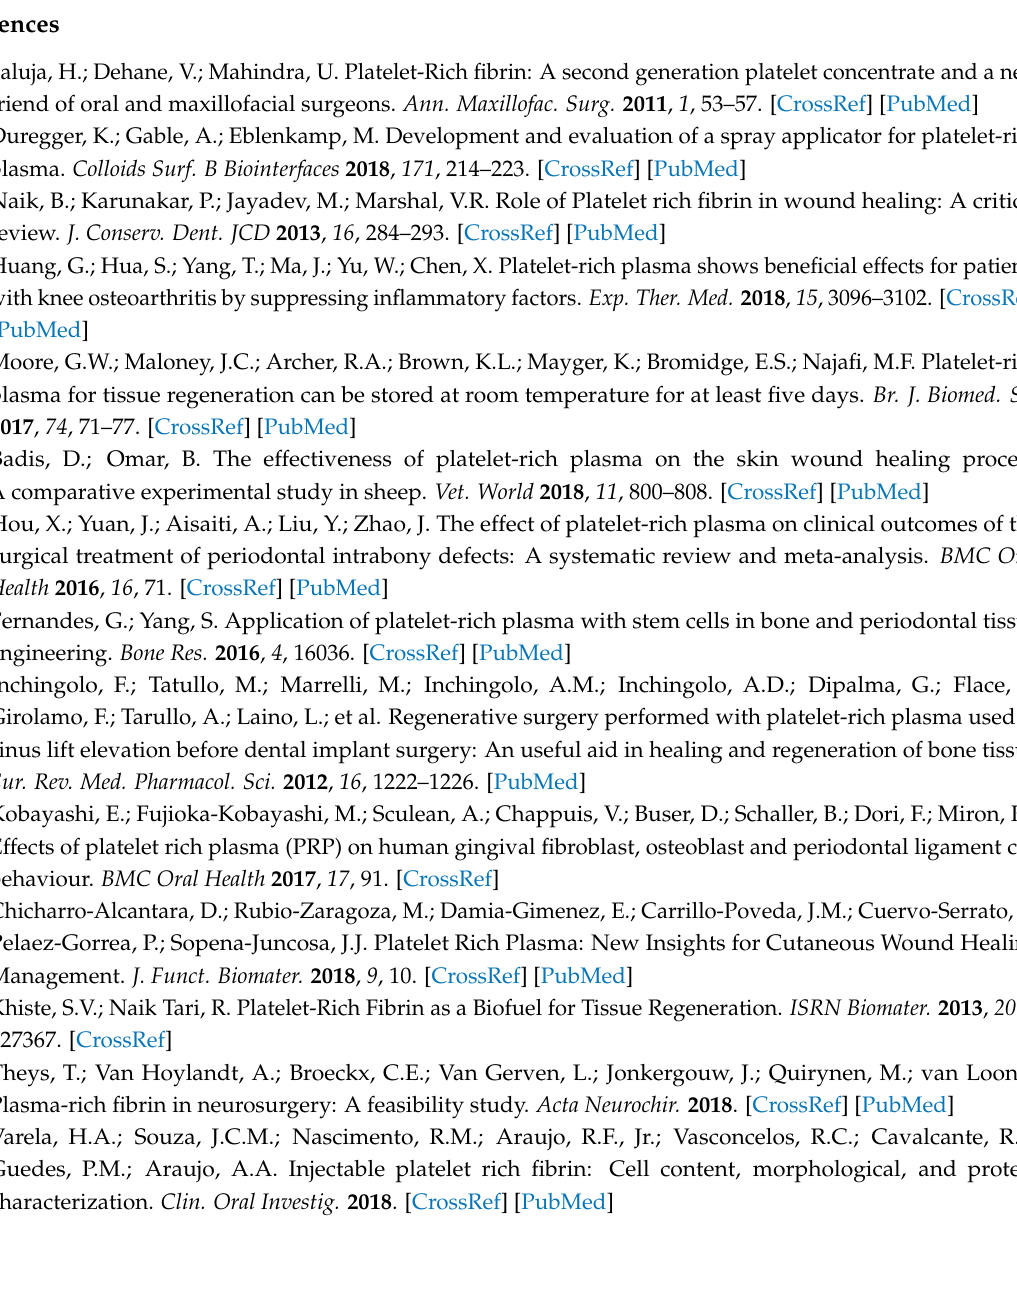
Supplementary Materials: The following are available online, Figure S1: PRF membrane preparation by glass blood drawing tube (A) and by a medical device, called hypACT Inject (B), Figure S2: Plasmin activity of frozen GT (A) and HI (B) PRF